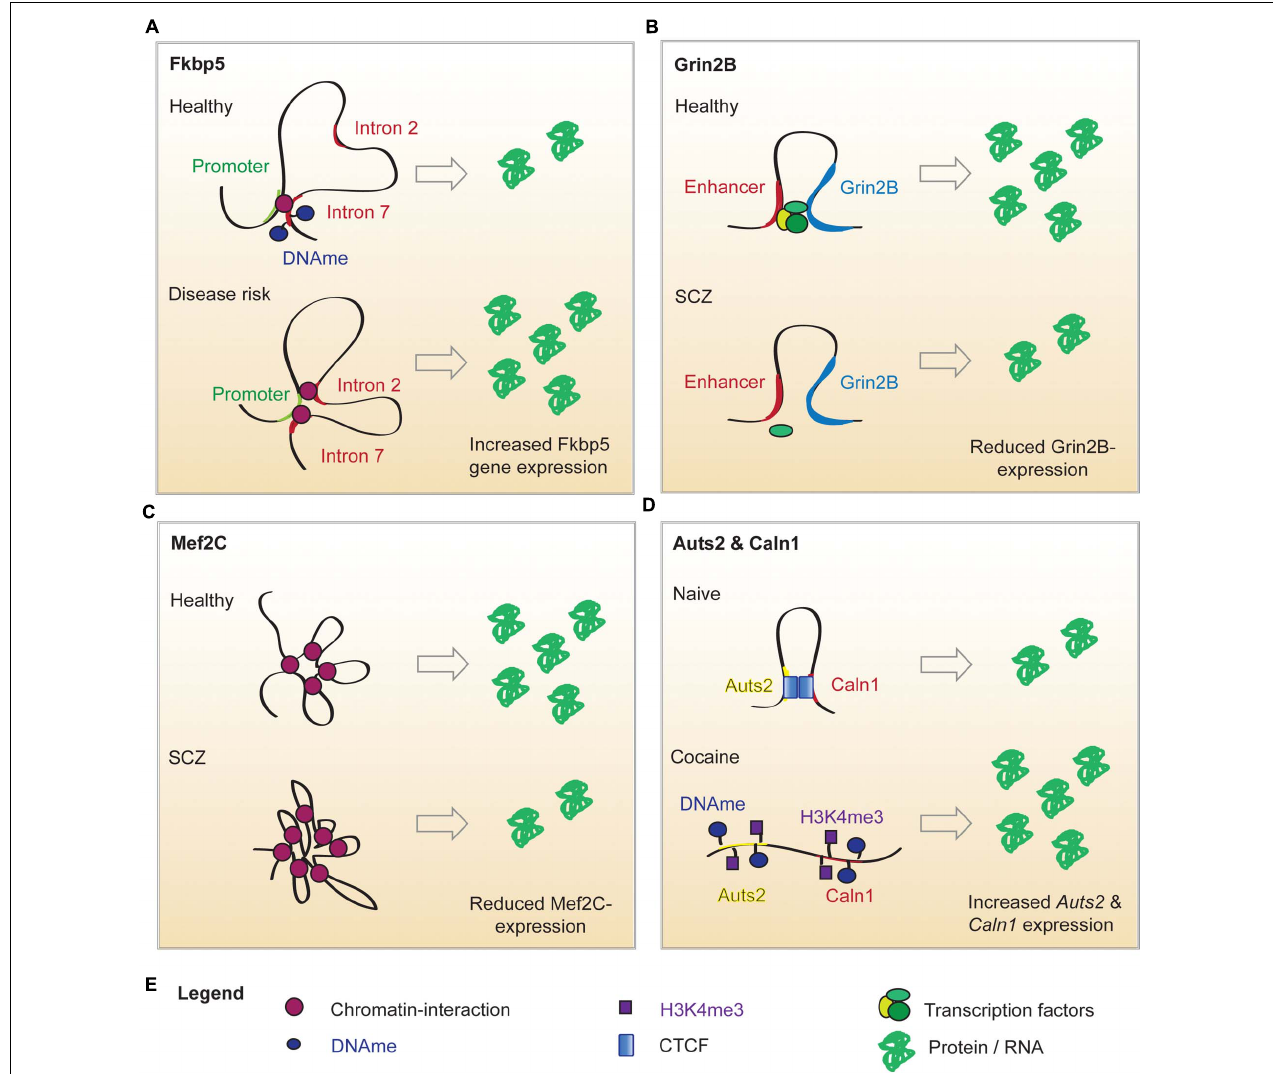
FIGURE 1 | Putative mechanisms of altered chromatin looping in mental illness. (A) Under normal conditions, the Fkbp5 promoter forms a chromatin loop with intron 7 of the Fkbp5 gene. When a risk allele is present, a second chromatin interaction between the promoter and intron 2 of the Fkbp5 gene forms. In consequence, Fkbp5 expression is increased and results in an altered stress response. (B) In healthy brains, Grin2b expression is upregulated by an enhancer-promoter loop. An SCZ-related SNP in the enhancer sequence decreases its’ ability to bind proteins. This has been hypothesized to impair enhancer binding to TFs and sharing them with the Grin2b locus. This could explain the lowered Grin2b expression in a subset of SCZ patients. (C) Mef2c expression is regulated by interactions with twelve long distance partners. A SCZ-related SNP in a distant enhancer leads to extensive loop interaction with the locus and ultimately results in lower Mef2c expression. (D) Cocaine administration alters the local chromatin landscape surrounding Auts1 and Caln2, which abolishes the looping interaction. This is associated with increased DNA methylation (DNAme), reduced CTCF binding and elevated levels of the permissive chromatin mark H3K4me3. This is associated with an elevated expression of the two